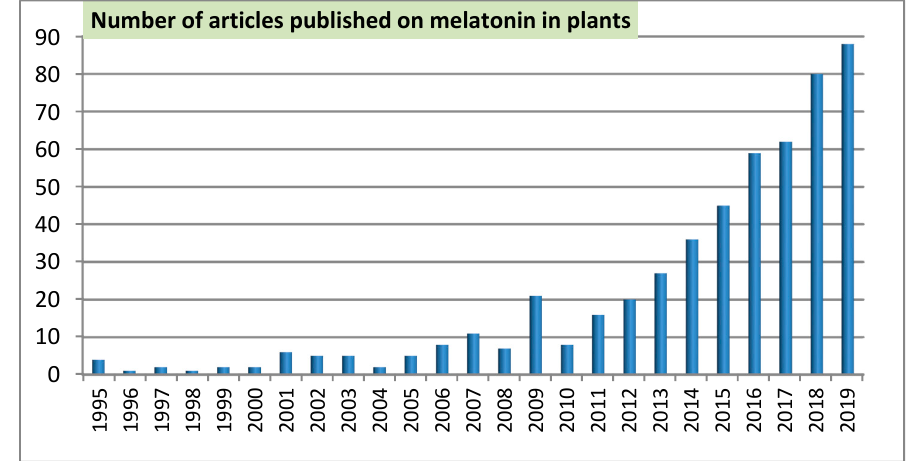
Figure 1. Evolution of the number of articles related with melatonin in plants since its discovery in 1995. For 2019, the data are based on an extrapolation of the data available to date (first 10 months).